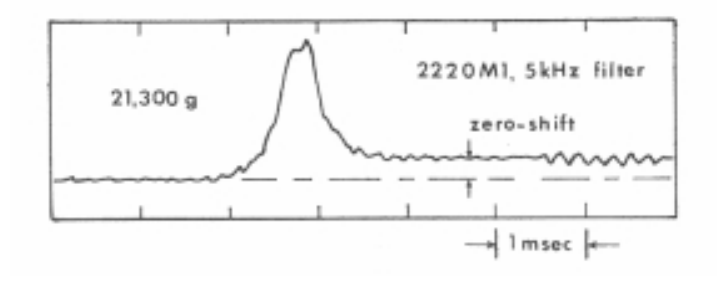
Fig. 8. Zero-shift from ferroelectric ceramic accelerometer (circa